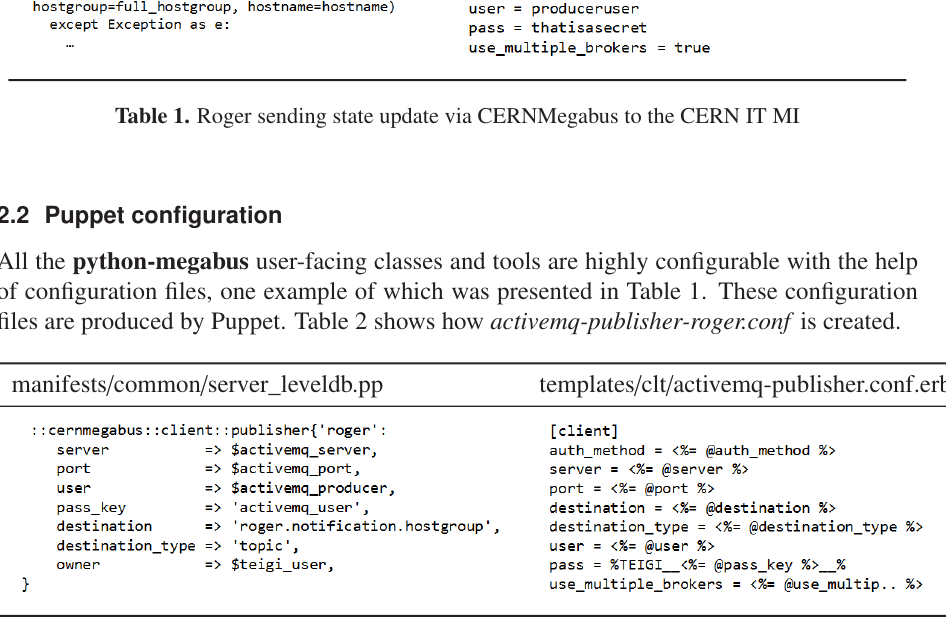
Table 2. Puppet configuration of roger CERNMegabus